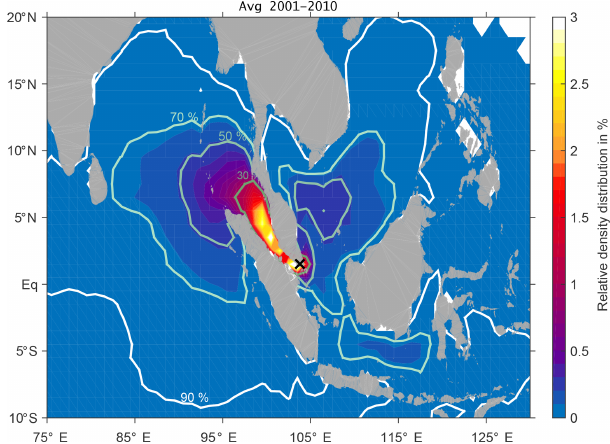
Figure 2. Annual mean surface (20m) spread of DBPs from dis- charge in the Pearl River Delta relative to the total number of parti- cles released. Contours show the area of the percentage of particles (30%, 50%, 70% and 90%) characterised by the highest density.